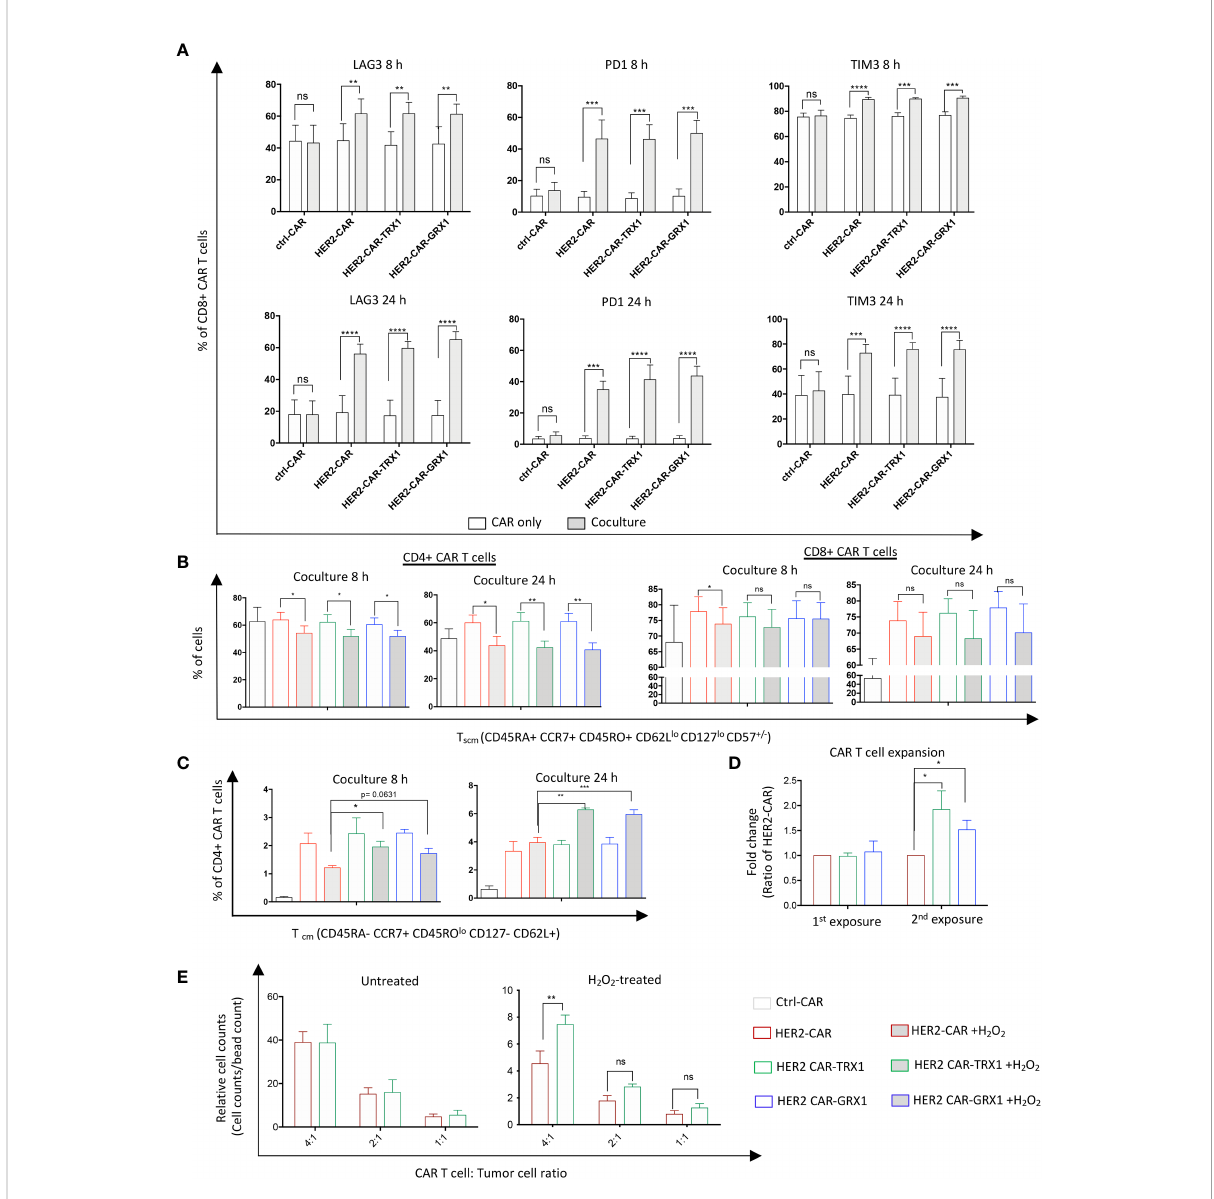
FIGURE 5 TRX1 and GRX1 overexpression does not in fl uence tumor cell-induced CAR T cell exhaustion. Ctrl-, HER2-, or antioxidant-enhanced CAR T cells were untreated or treated with H 2 O 2 and cocultured with SKBR3 cells for 8 and 24 h. Then, CAR T cells were collected and immunostained for exhaustion markers or markers to discriminate memory cell phenotypes. (A) Percent expression of LAG3 (left), PD1 (middle), and TIM3 (right) in CD8+ CAR T cells after 8 (upper graphs) and 24 (lower graphs) h of CAR only culture (white bars) and CAR T cell/SKBR3 coculture (grey bars). Data represent mean ± SEM (n ≥ 3; * p < 0.05, ** p < 0.01, *** p < 0.001, **** p < 0.0001, ns = non-signi fi cant). (B) Percent CD4+ (left graphs) and CD8+ (right graphs) T scm CAR T cells in 8 and 24 h CAR T cell/SKBR3 cocultures under control and pro-oxidative conditions. (C) Percent CD4+ CD45RO lo T cm cells at 8 h (left graph) and 24 h (right graph) CAR T cell/SKBR3 cocultures under control and pro-oxidative conditions. Data represent mean ± SEM (n ≥ 3; * p < 0.05, ** p < 0.01, *** p < 0.001, ns = non-signi fi cant). (D) Expansion capacity of CAR T cells after single (1st exposure) and double (2nd exposure) culture with SKBR3 tumor cells. After coculture (5 days) CAR T cells were collected and stained with anti-CD3 antibody and viability dye. Then, samples were mixed with equal amounts of beads. Relative expansion was calculated in relation to bead counts by fl ow cytometry. Data represent mean ± SEM (n ≥ 3; * p < 0.05, ns = non-signi fi cant). (E) Expansion capacity of CAR T cells in SKBR3/CAR T cell cocultures after 5 days. Data represent mean ± SEM (n ≥ 3; * p < 0.05, ** p < 0.01, ns = non-signi fi